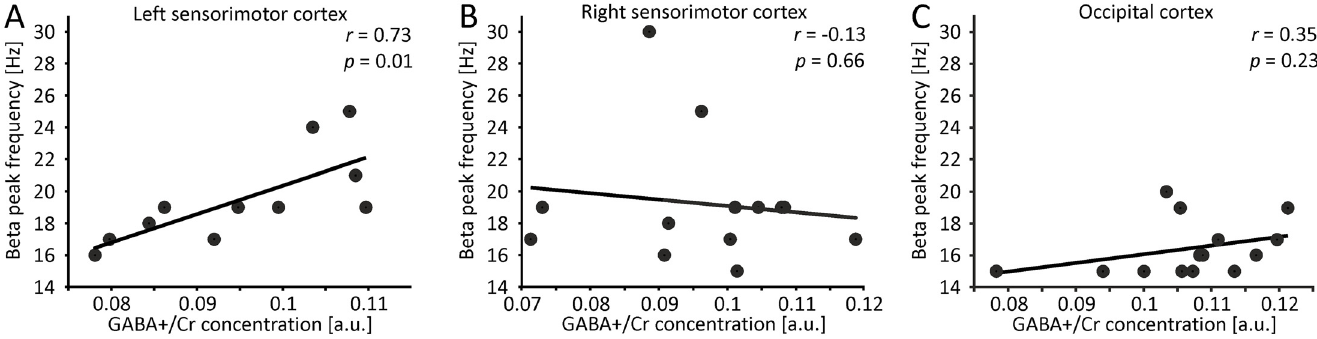
Fig 3. Correlation of beta peak frequencies and GABA+/Cr concentration. (A) Beta peak frequencies calculated for the left sensorimotor MEG ROI and the EC+EO condition correlated with GABA+/Cr estimates from the left sensorimotor MRS ROI. (B) Same as (A), but now for right sensorimotor MEG and MRS ROI. (C) Same as (A), but now for occipital MEG and MRS